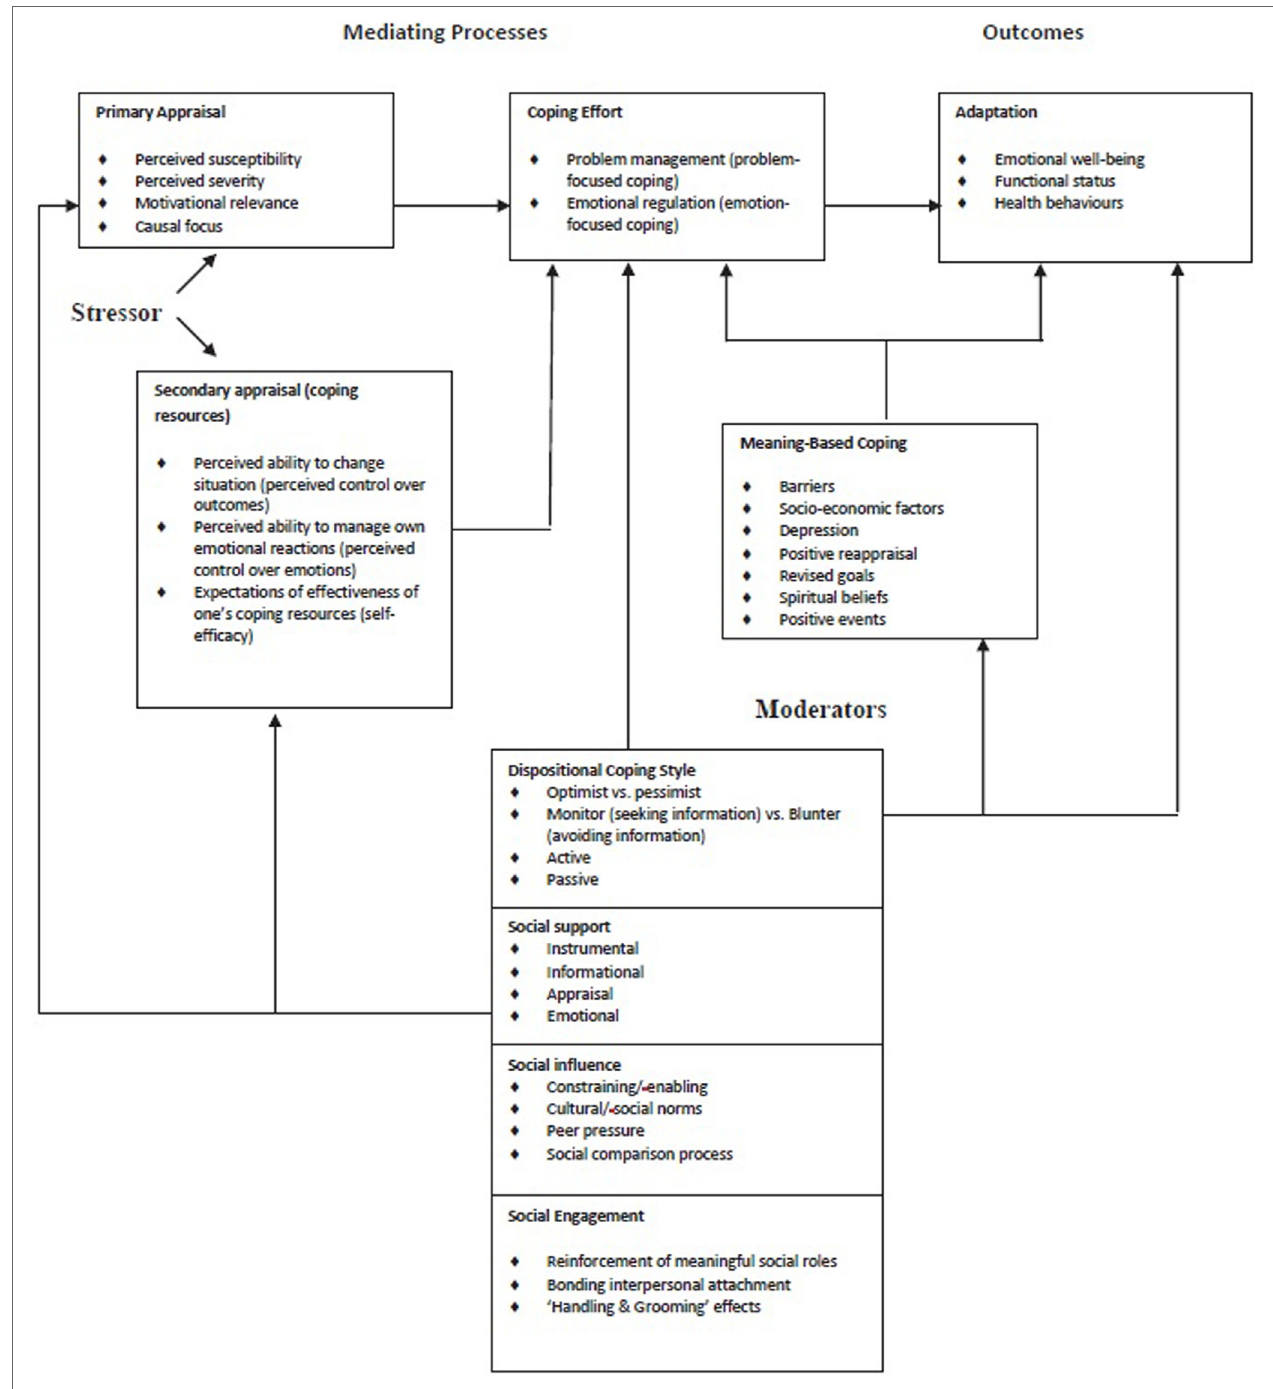
FigUre 3 | Transactional model of stress and coping combined with the social network model of Berkman and Kawachi (50).